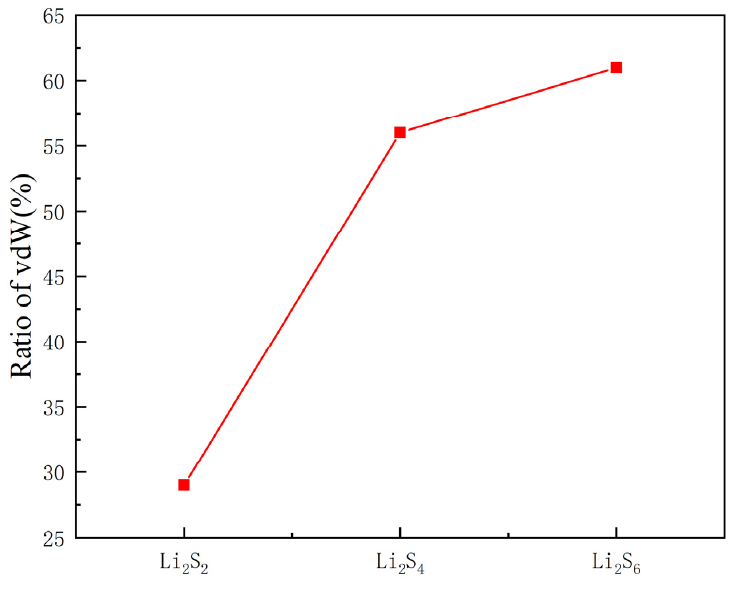
Figure 8. Ratios of vdW interaction for Li 2 S x (x = 2, 4, 6) species on Ti 2 NS 2 .